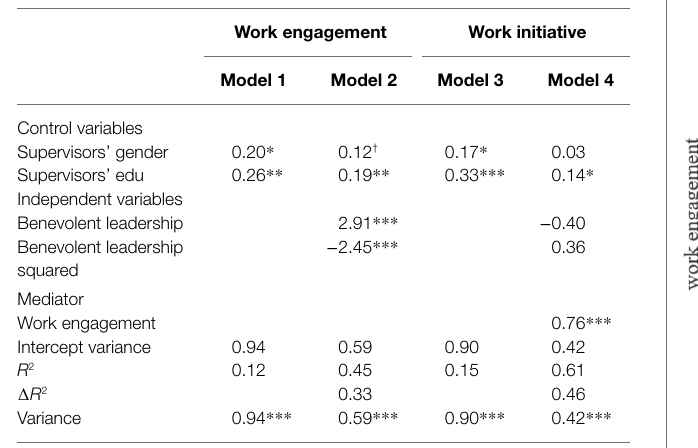
FIGURE 3 | Inverted-U relationship between benevolent leadership and work engagement at the team